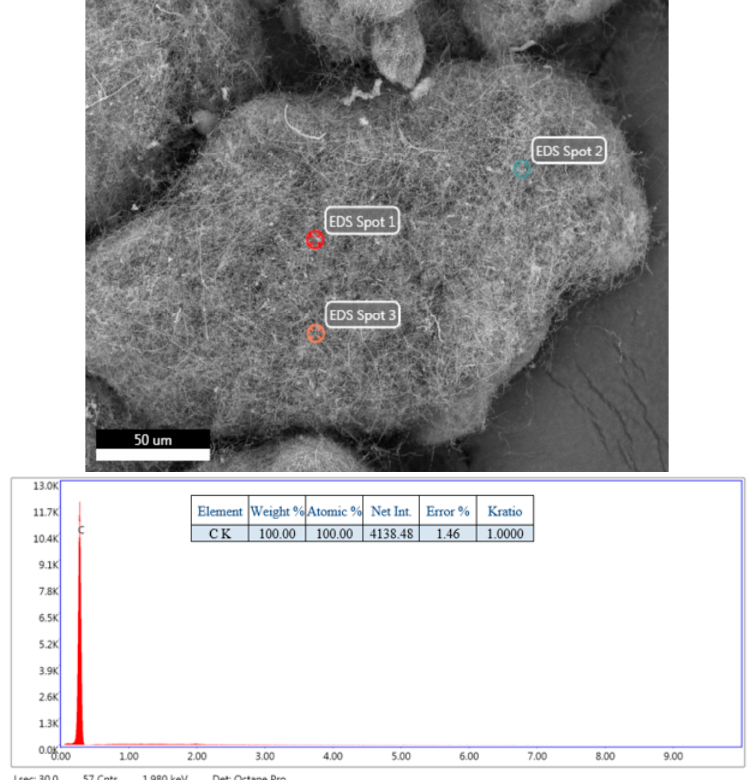
Figure 3. EDS of electrospun carbon nanofibers (ECNFs) after carbonization in argon for 1 h at a peak 500 °C in a single step with a 5 °C/min heating rate.